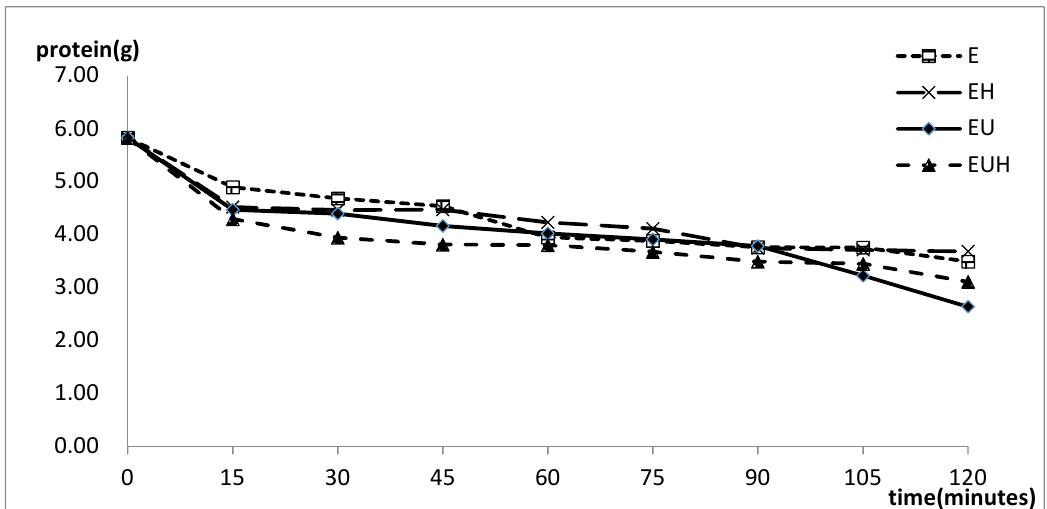
Figure 1. The protein content changes in different groups with the time.